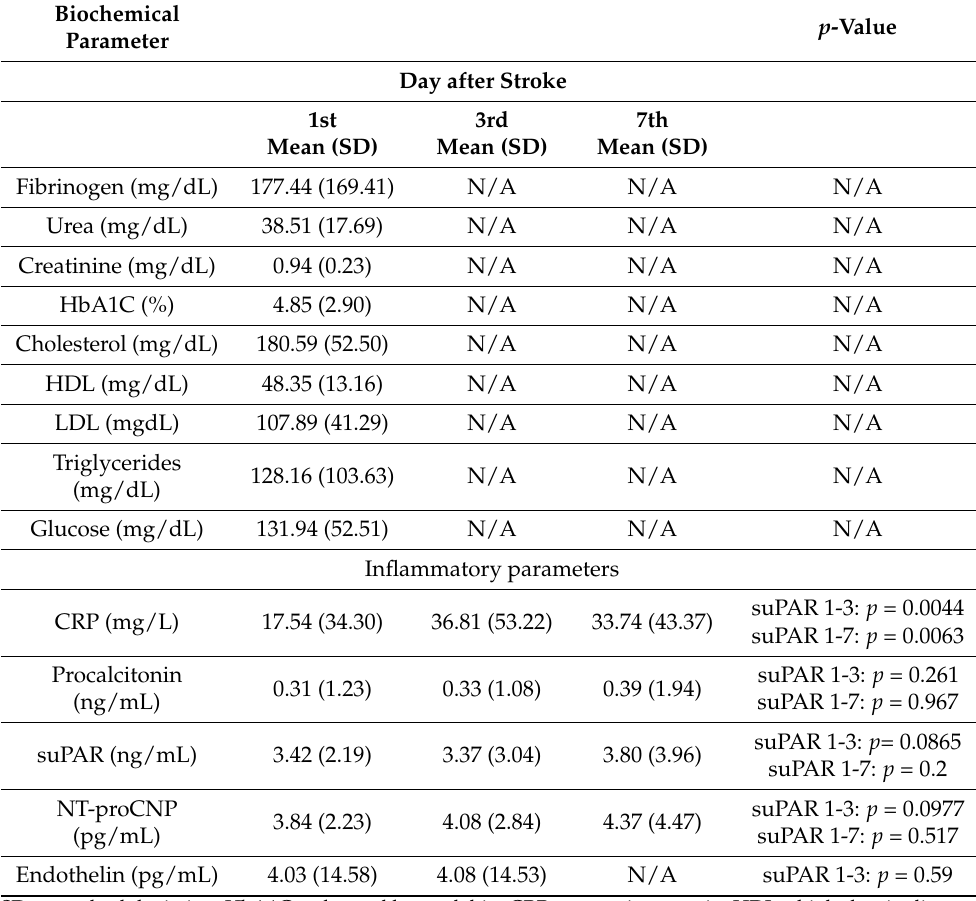
Table 2. Biochemical parameter data.